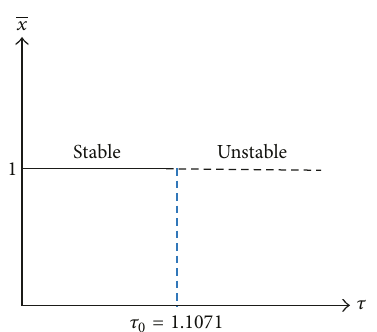
Figure 4: Bifurcation diagram for Example